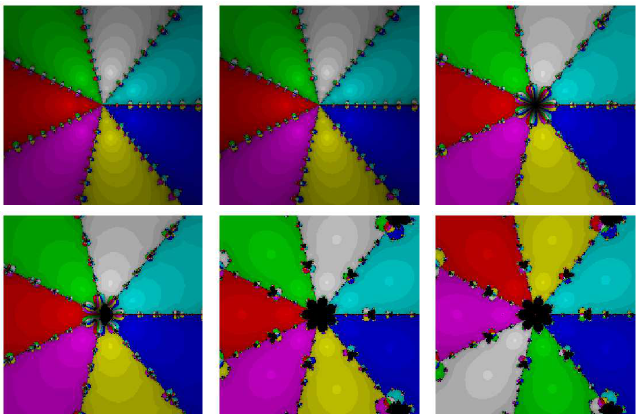
Figure 5. The basins of attraction for RM 2 , MRM 2 , HM 3 , MHM 3 , SM 3 and MSM 3 , from left to right and top to bottom, respectively in Problem 3.